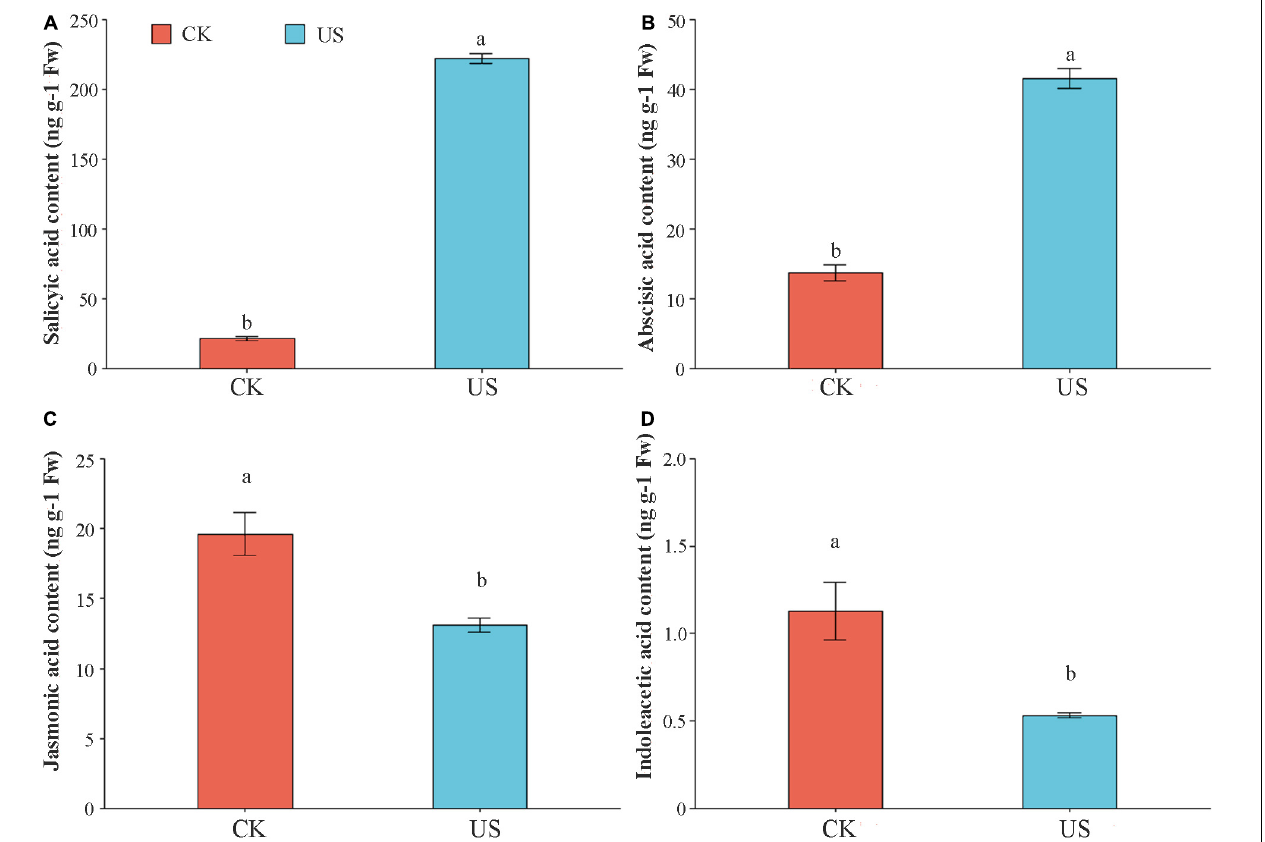
FIGURE 6 | The effect of ultrasonic treatment on salicylic acid (SA) (A) , abscisic acid (ABA) (B) , indole acetic acid (IAA) (C) , and jasmonic acid (JA) (D) . Marking the same letters means P ≥ 0.05 (LSD), and there is no significant difference; the difference between different letters means P < 0.05 (LSD), and the difference is